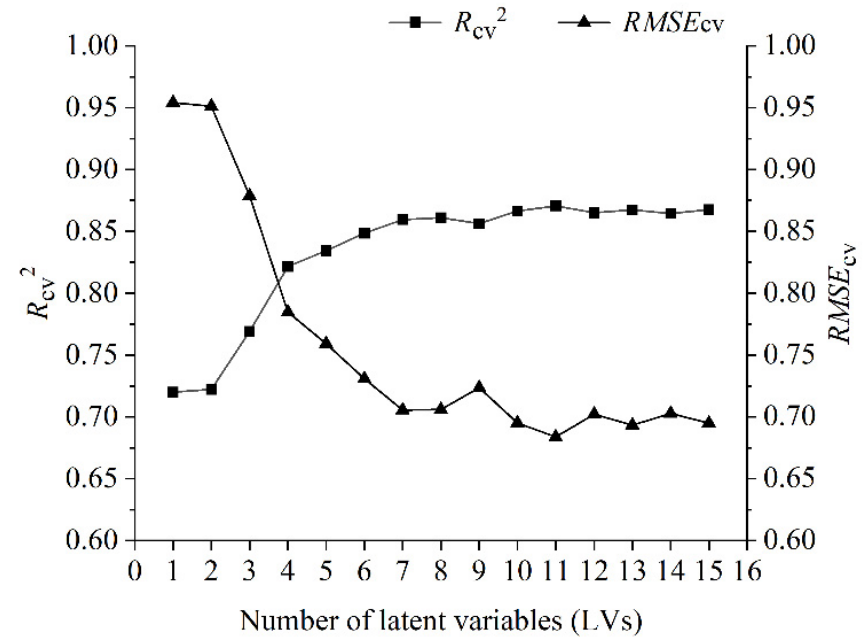
Figure 5. Cross-validation result for PLSR.